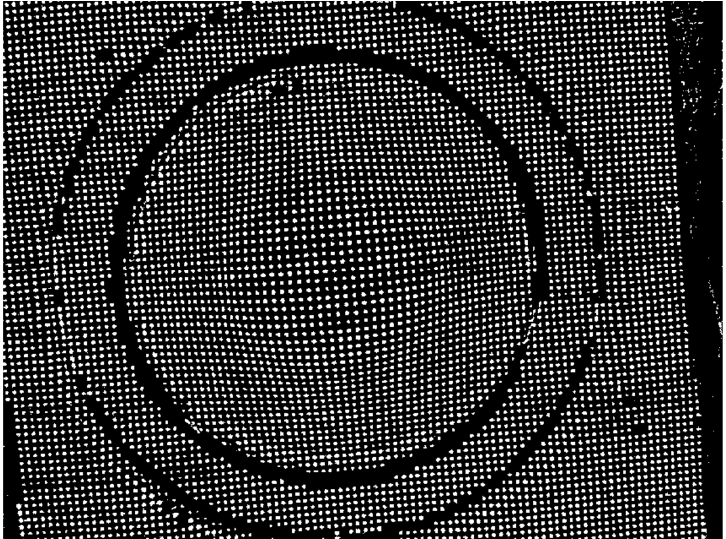
Figure A2. Binarized left-side photography to obtain a candidate’s marks.